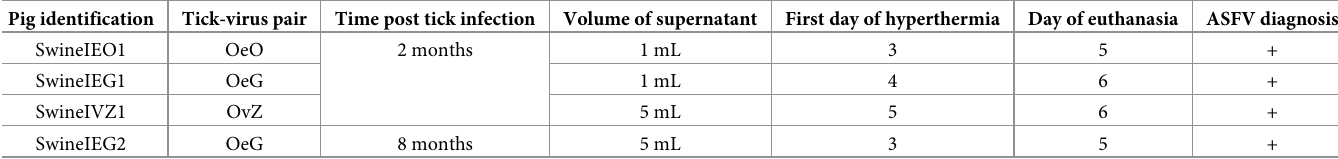
Table 4. Clinical outcome in pigs inoculated with homogenate supernatant of O . erraticus and O . verrucosus previously exposed to selected ASFV strains. Experi- ments involved ticks previously exposed to ASFV strains. OeO = O . erraticus -OurT88/1, OeG = O . erraticus -Georgia2007/1, OvZ = O . verrucosus -Zapo.